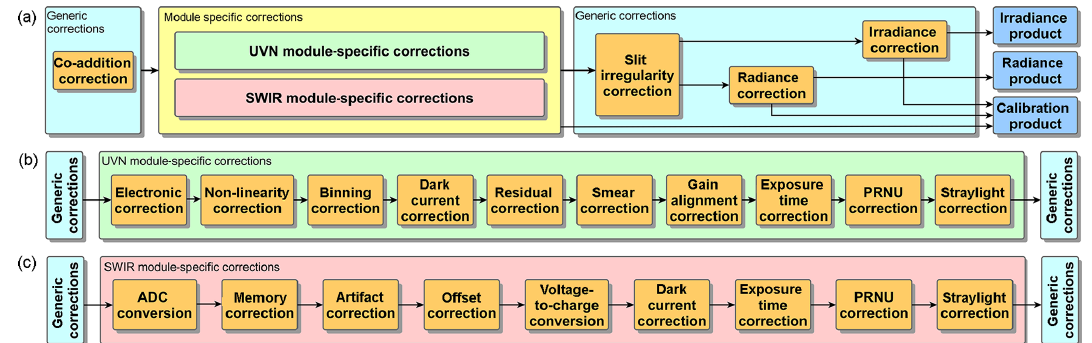
Figure 3. (a) High-level overview of the different processing steps in the L01b processor. For the output products “radiance”, “irradiance”, and “calibration”, different algorithms are applied. The generic corrections are applied to all detectors. Panels (b) and (c) show the module- specific correction steps that differ between the UVN and SWIR modules. Note that not all processing steps are shown. In this paper all generic and UVN-specific corrections are discussed as well as the SWIR pixel response non-uniformity (PRNU). The other SWIR-specific corrections are presented in Hoogeveen et al. (2013) and Tol et al. (2018).